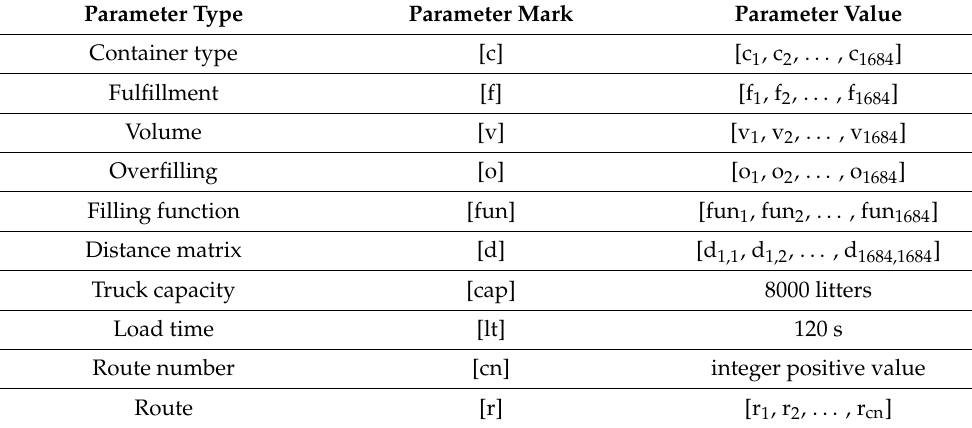
Table 2. The parameters of planning the garbage truck